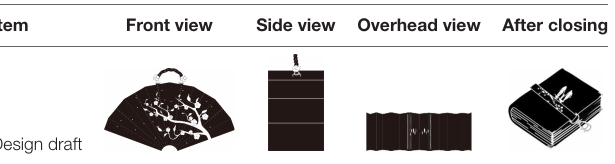
TABLE 2 | Student A’s final draft design, “winter flowers.”